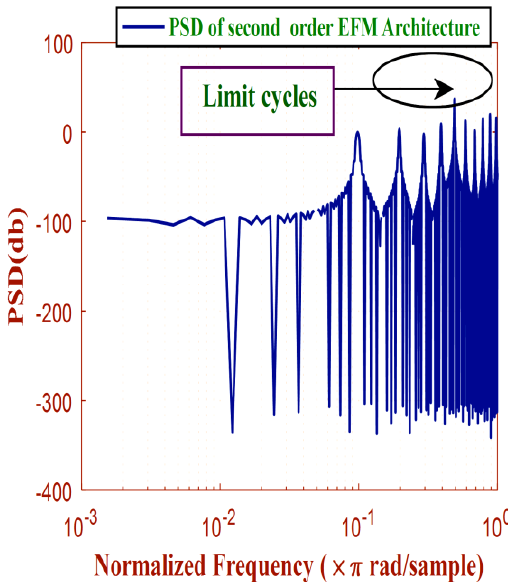
Figure 11. PSD of 2nd order conventional EFM.